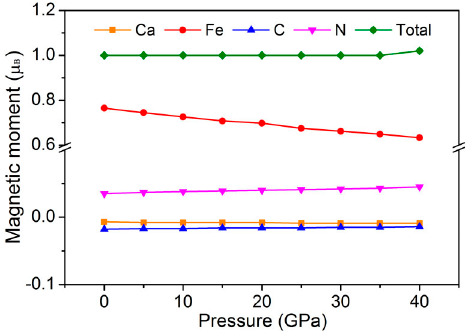
Figure 9. Total and local magnetic moments of GaFe(CN) 6 under